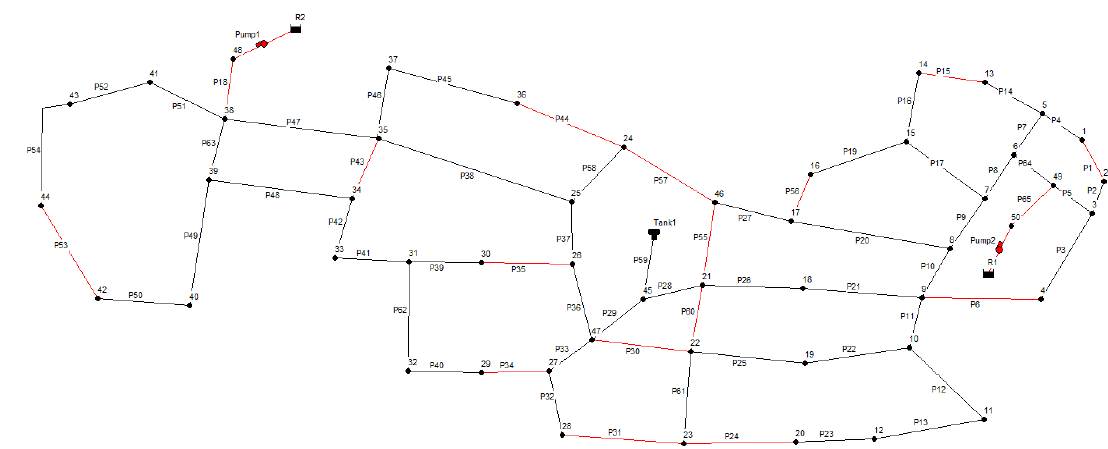
Figure 7. Layout of a real-life network (the chord tree pipes are highlighted in